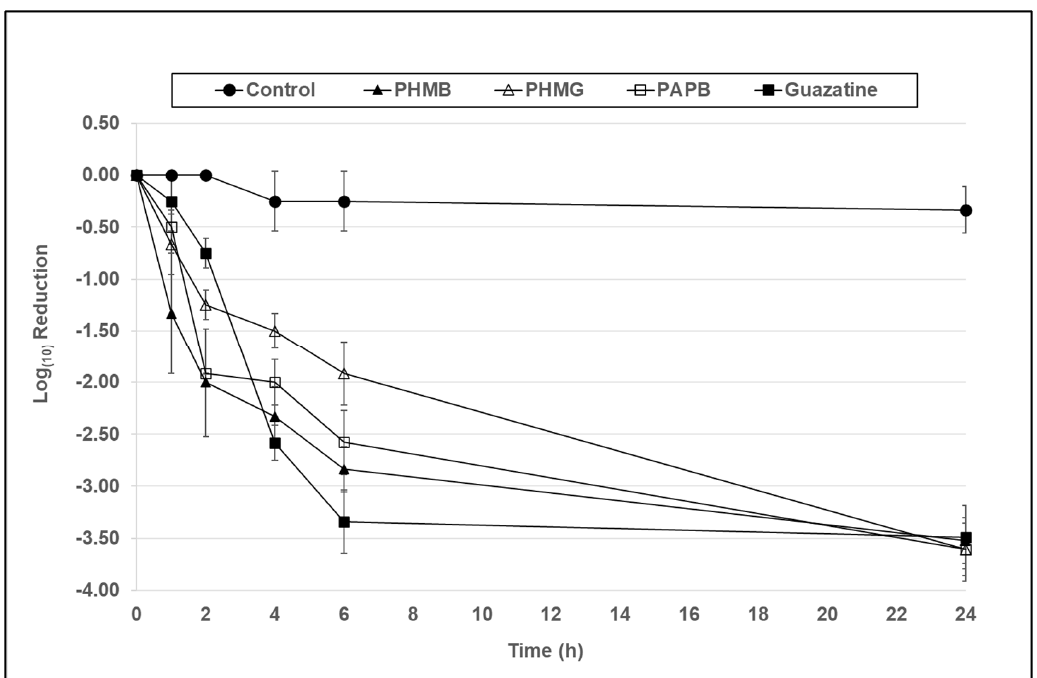
Figure 2. The antimicrobial activity of PHMB, PHMG, PAPB, and guazatine against A. castellanii (ATCC 50370) trophozoites over a 24 h period at a concentration of 7.8 µg/mL formulated in a con- tact lens base solution. Error bars show the standard error of the mean (SEM) from triplicate exper- iments.